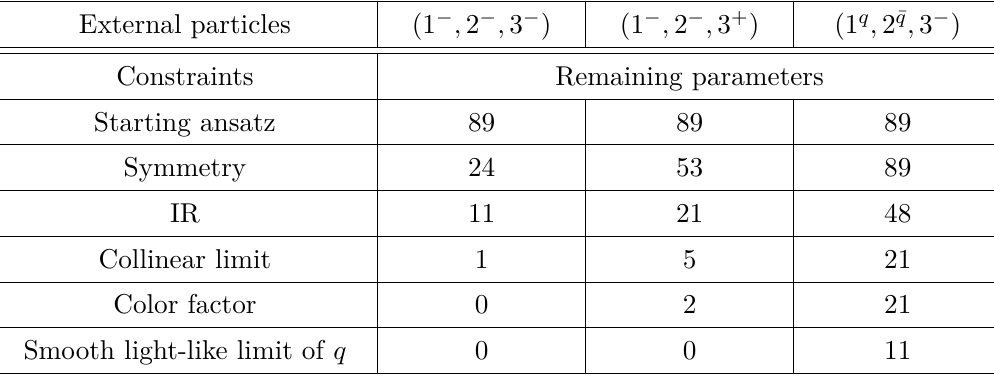
Table 3. Bootstrap for two-loop form factors of tr( F 2 )